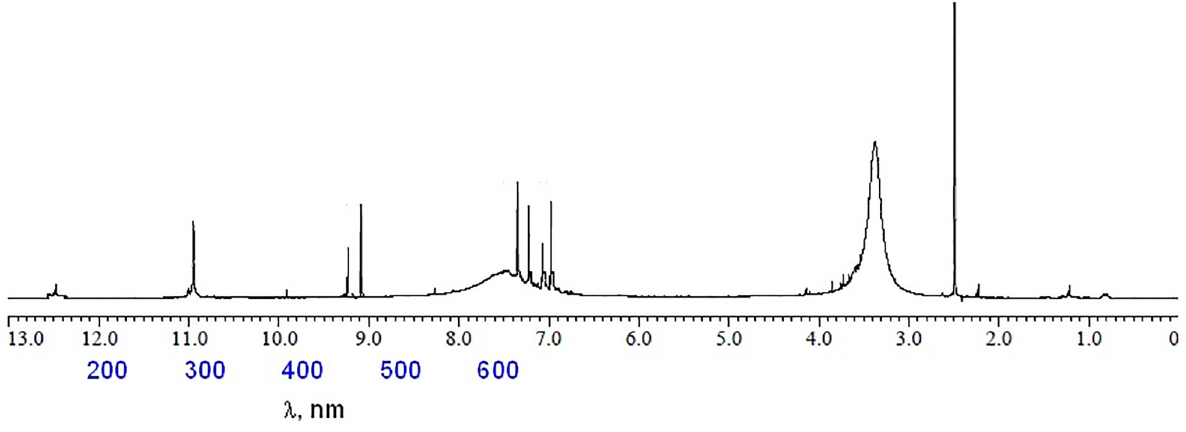
Fig 5. 1 H-NMR spectrum of zinc(II) complex.